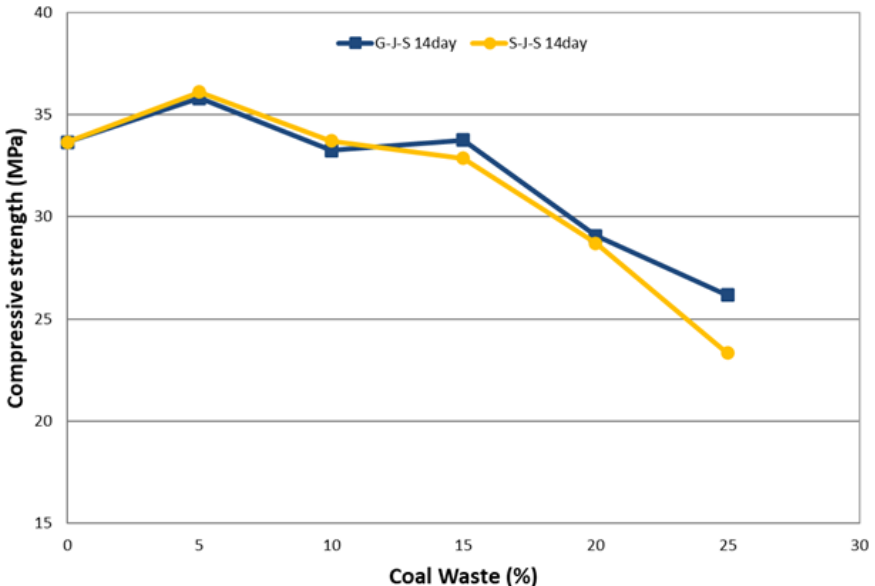
Figure 9. Effect of type and amount of coal waste on the compressive strength after 14 days.